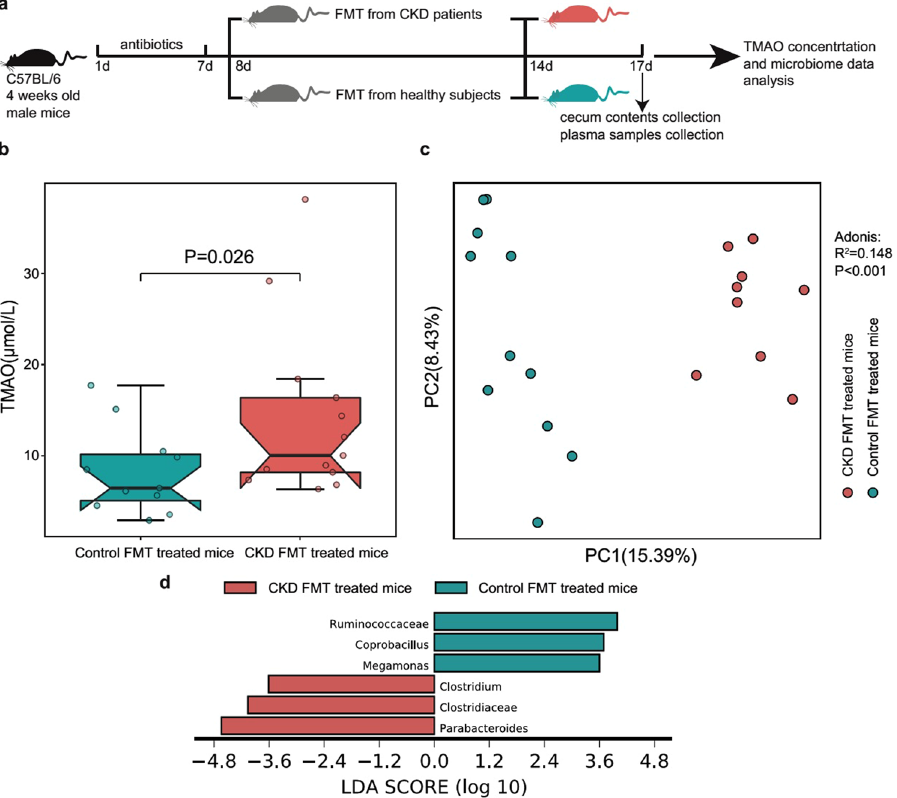
Figure 4. Transplantation of the CKD patient microbiota induces an increased TMAO level and dysbiosis of the gut microbiota in antibiotic-treated mice. The data represent 12 mice transplanted with healthy control faecal samples (blue) and 13 mice transplanted with CKD patient faecal samples (red). ( a ) Experimental design of the faecal microbiota transplantation (FMT) in antibiotic-treated mice. ( b ) Comparison of the plasma TMAO levels between the groups of mice after transplant with pooled faecal samples from the CKD patients and healthy controls. The Mann-Whitney U test was used to determine significance between groups. ( c ) Principal coordinate analysis illustrating the grouping patterns of the two groups of mice based on the unweighted UniFrac distances. Each open circle represents a sample. Distances between any pair of samples represent their dissimilarities. ( d ) Significantly discriminative taxa between the two group of mice were determined using Linear Discriminant Analysis Effect Size (LEfSe). Only taxa meeting the LDA significance thresholds ( > 3) are shown. Different coloured bars represent different